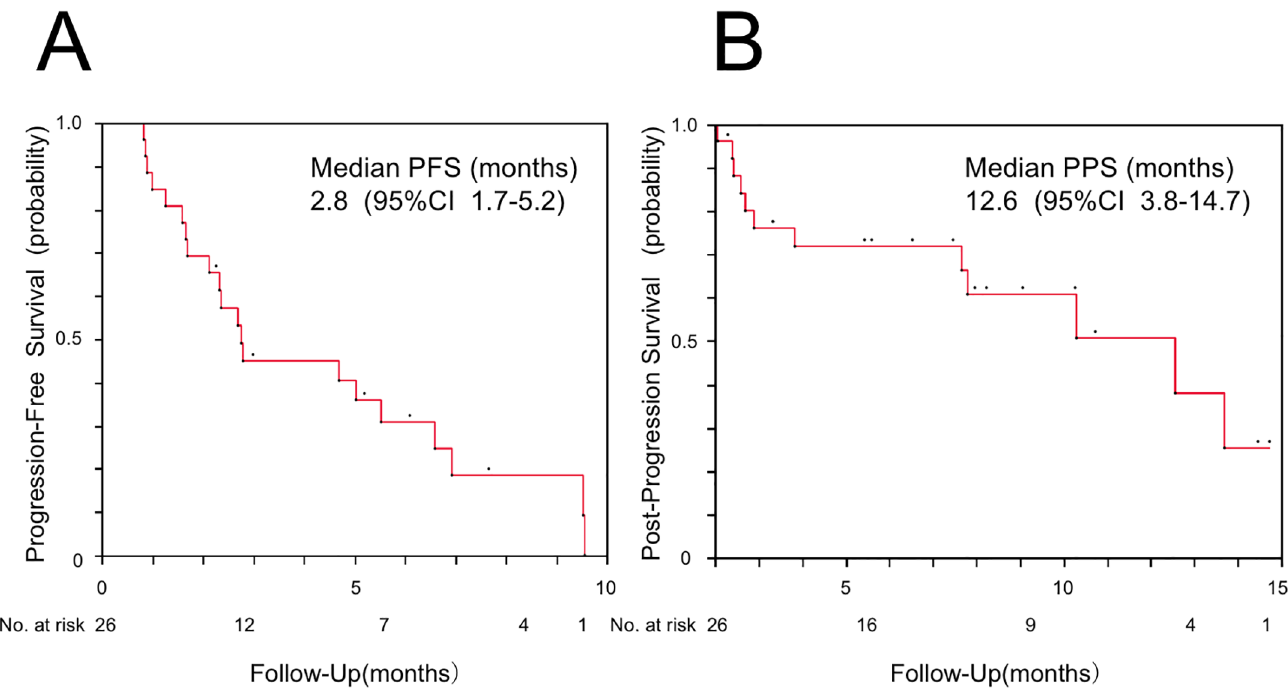
Fig 2. Kaplan-Meier plot. (A) progression-free survival (PFS) of first-line post-nivolumab treatment and (B) post-progression survival (PPS) after cessation of treatment with nivolumab in 26 patients who received post-nivolumab chemotherapy. The PFS was calculated from the date of initiation of first-line post- nivolumab treatment and the PPS was calculated from the date of diagnosis of progressive disease during nivolumab treatment. CI; confidence interval.